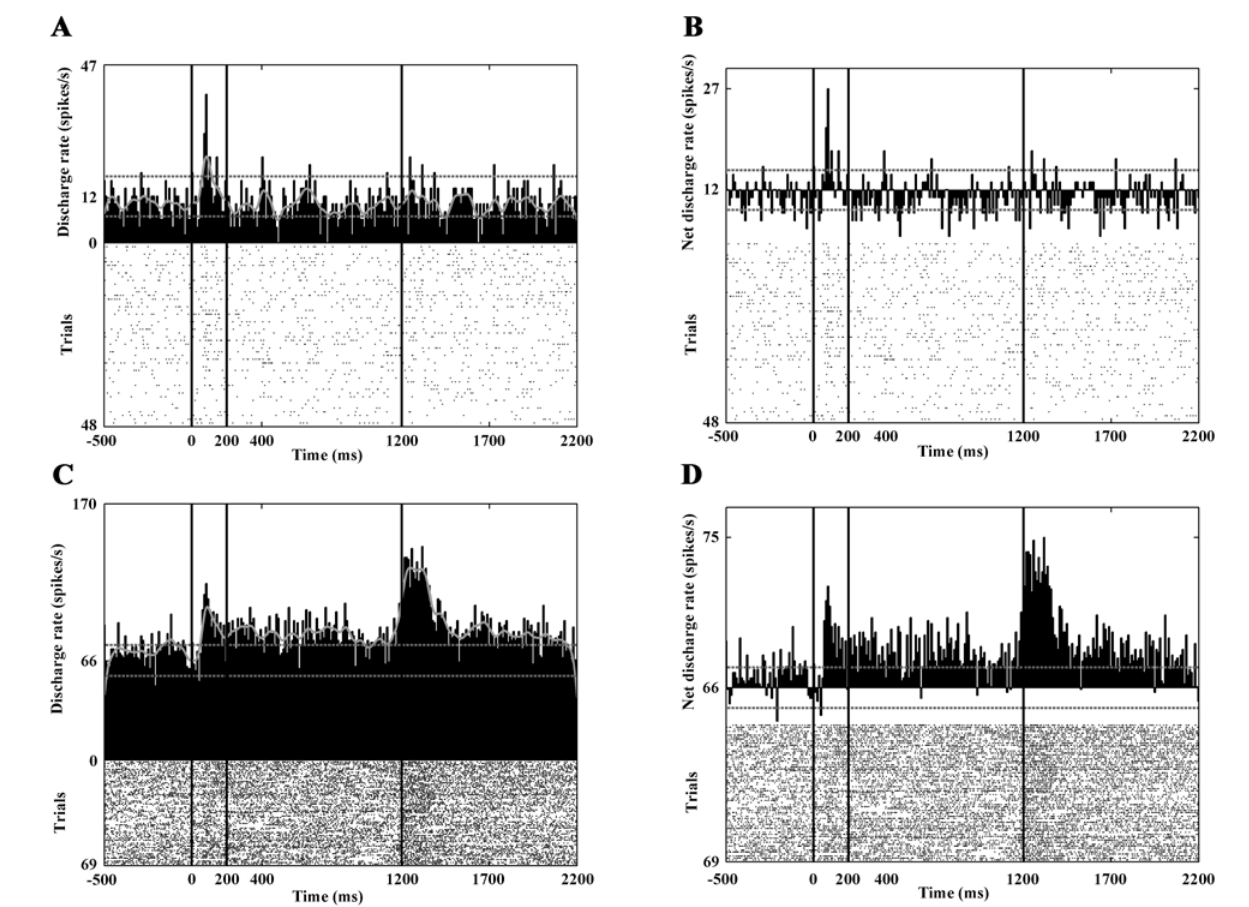
Fig 3. Response characteristics of the CN neurons to static visual stimulation. Each panel of the figure contains a PSTH (top) and a raster plot (bottom) to represent the activity of a neuron. Panels A and B show the activity of a PAN, panels C and D show the firing pattern of a HFN. A and C show the gross activities, B and D show the net activity change after the subtraction of the background activity. The vertical black lines denote the boundaries between the different phases of the paradigm: fixation phase (-500 to 0 ms), static visual stimulation (0 to 200 ms), dynamic visual stimulation (200 to 1200 ms), reward phase (1200 to 1700 ms). Note the phasic response of the PAN to static stimulation (A,B). The activity pattern of the presented HFN (C,D) is more complex: increased activity can be observed not only to random dot patterns, but also to optic flow and during the reward phase. The abscissa denotes the time in milliseconds. The ordinate denotes the number of successful trials and the activity of the neuron. The lowest number is the number of the successful trials, the next is the average discharge during the whole recording and the highest number is the stimulated activity (Hz). The continuous grey curve is a smoothed curve of the activity, and the dashed grey lines indicate ± 2 SD of the average background discharge rate in the whole recording.